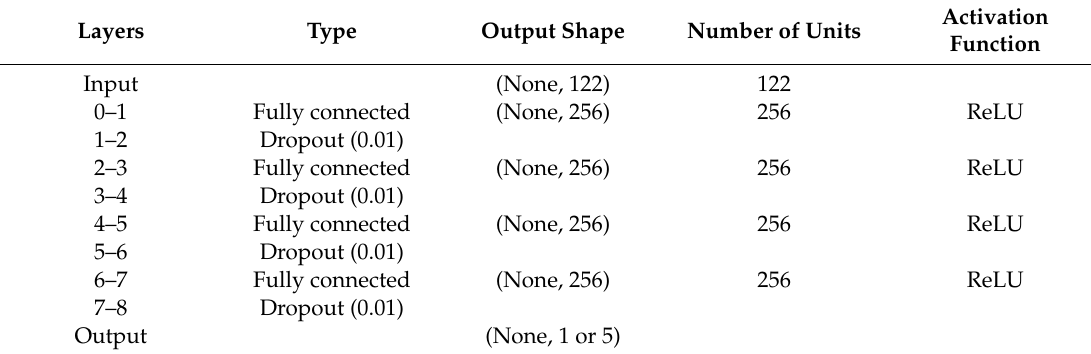
Table 2. The architecture of